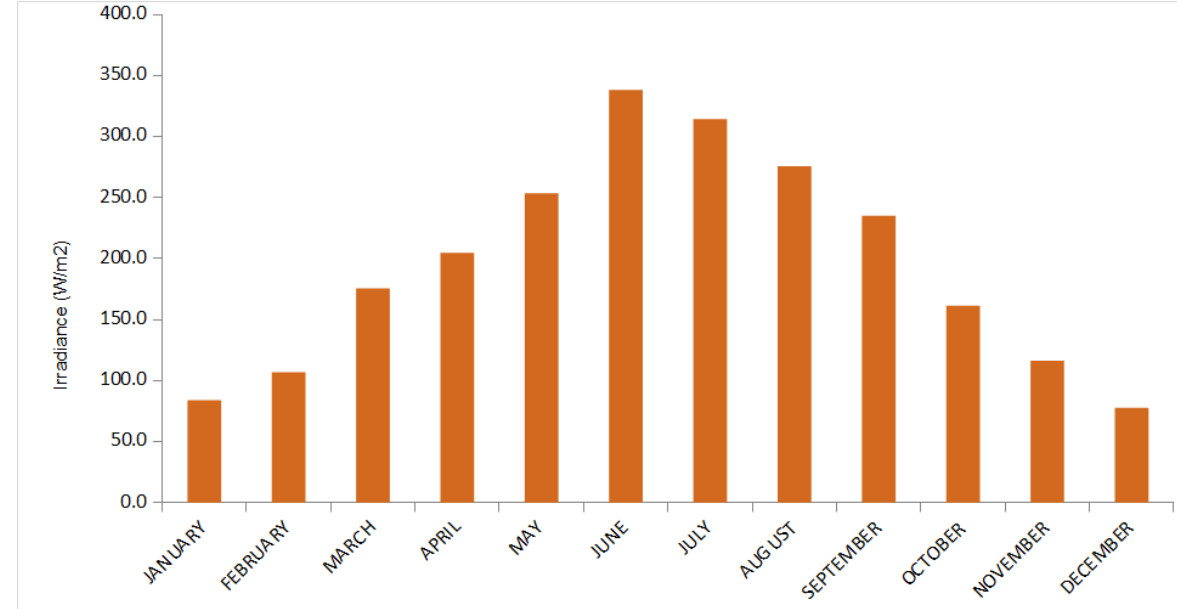
Figure 2. Average monthly solar irradiance used in the case study. Similar systems were compared previously [32] for Mediterranean areas, leading to the conclusion that hybrid photovoltaic/wind systems do not offer high availability due to the low wind potential observed in the examined area. The chosen location was not considered ideal in comparison to other areas because of the low yearly average wind speed of 2 m/s. Figure 3 shows the wind statistics based on the measurements taken for each month of the year from weather stations in Crete. The highest annual probability occurs at 3 m/s, which is in reasonable agreement with the probability density of the location